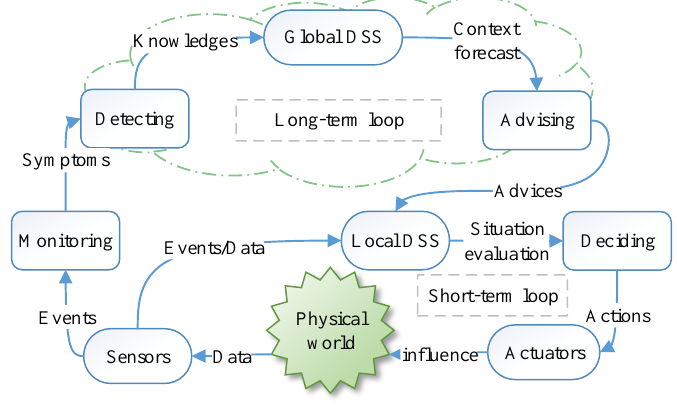
Figure 2. The environment-in-loop self-adaptation process of CPS.